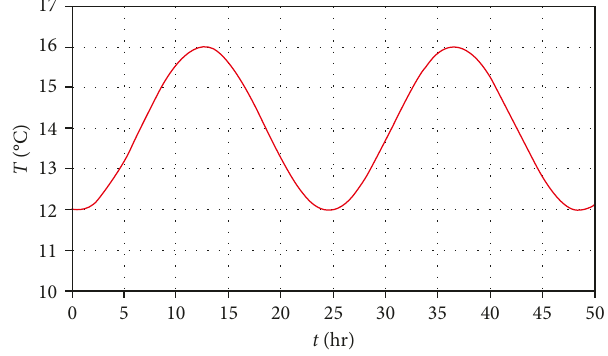
Figure 5: Atmospheric temperature model.